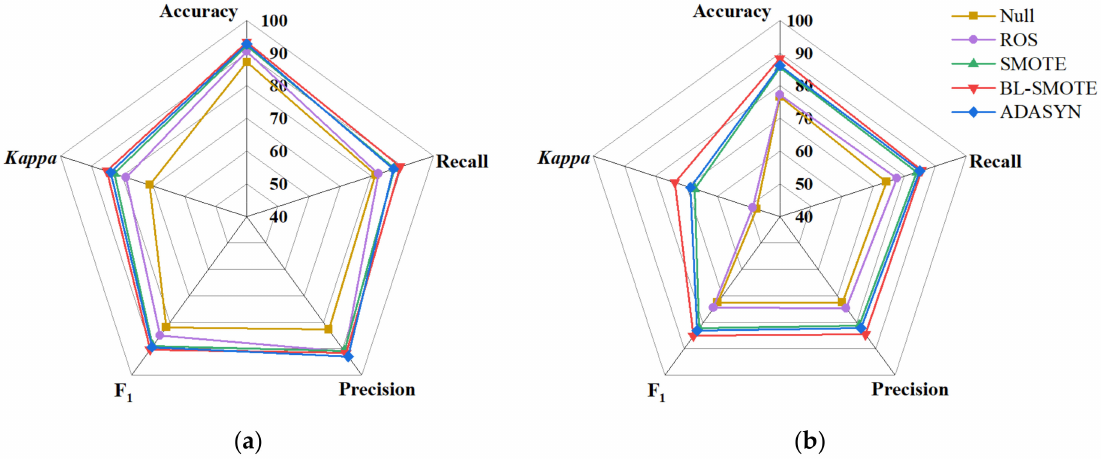
Figure 4. Comprehensive evaluation indexes (%) of test set: ( a ) SVM model; ( b ) PLS-DA